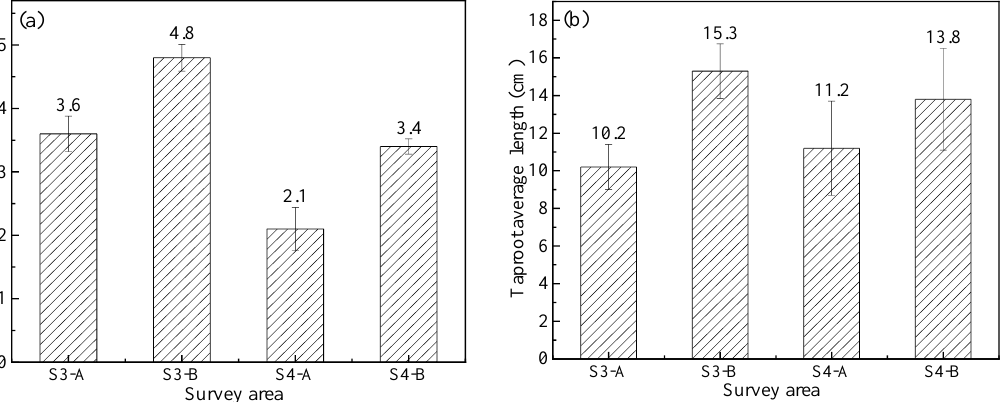
Figure 11. The taproot size survey in different areas in Figure 5: ( a ) average taproot diameter, and ( b ) average taproot